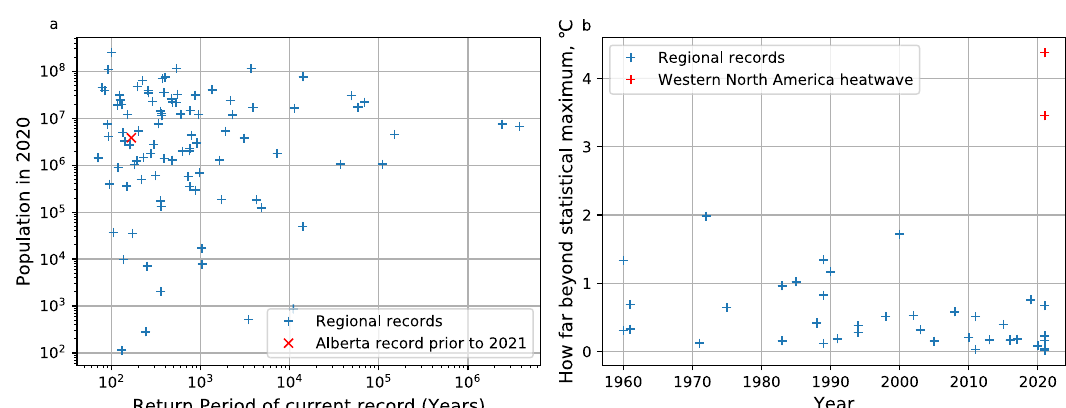
Fig.3|Currentrecordreturnperiodvpopulation.a Returnperiodofthecurrent recordagainstthecurrentpopulationoftheregion 33 fortheregionswhereareturn period can be calculated. The red cross indicates the values for the Alberta region excluding the 2021 event (as in Fig. 1c, d). b Regions with statistically implausible